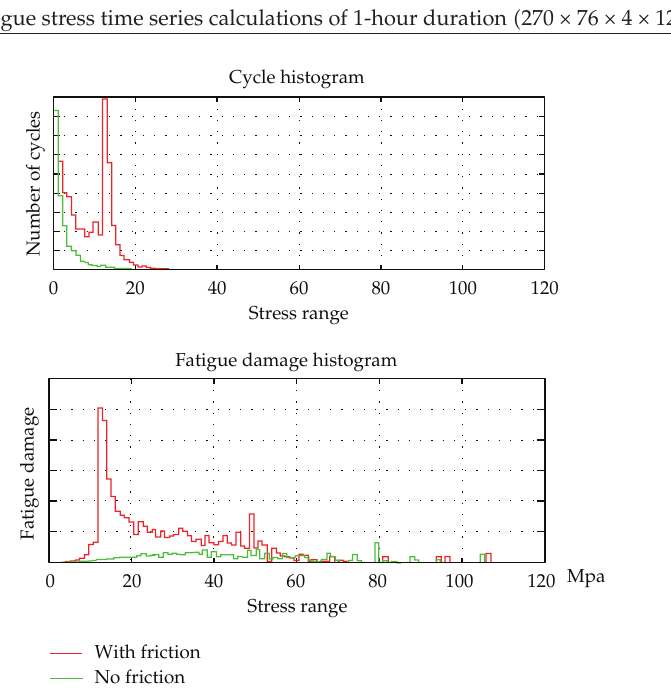
Table 4: Key figures for the helix fatigue analysis. Number of hot-spots (cid:6) corner points (cid:7) 4 Number of helix locations